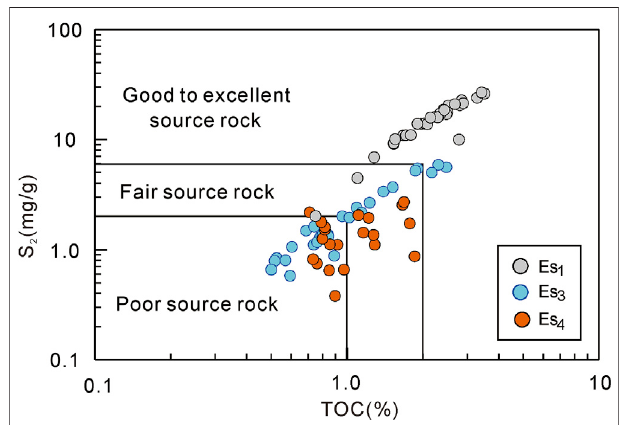
FIGURE 4 | Ternary diagram of the mineralogy of the Es 3 and Es 4